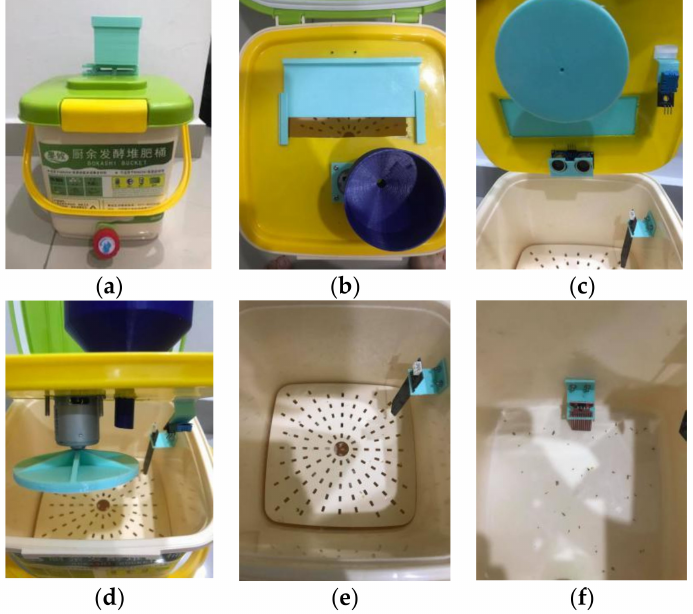
Figure 3. The components of the smart composting bin. ( a ) Shows the external view of the smart composting bin; ( b ) shows the additional cover on the composting bin; ( c ) shows the ultrasonic sensor and temperature and humidity sensor at the backside of the cover; ( d ) shows the DC motor and the spindle attached on the cover; ( e ) shows the soil moisture sensor attached on the wall of the bin; ( f ) shows the water level sensor attached to the bottom of the composting bin. Moreover, the capacitive soil moisture sensor’s signal was connected to pin A2, while the signal of the water sensor was connected to pin A3. Other than that, the pins of trigger and echo in ultrasonic sensors were connected to D7 and D6, respectively. Schematic diagram of the circuit, is as shown in Figure 4.